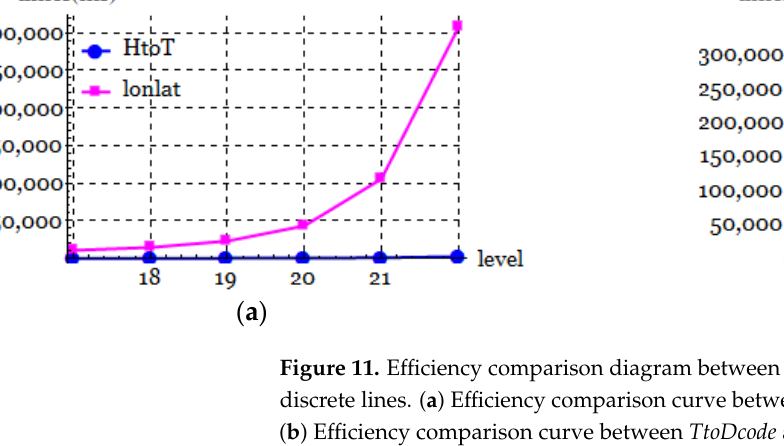
Figure 12 is the superposition diagram of the ninth level HtoTcode triangle discrete